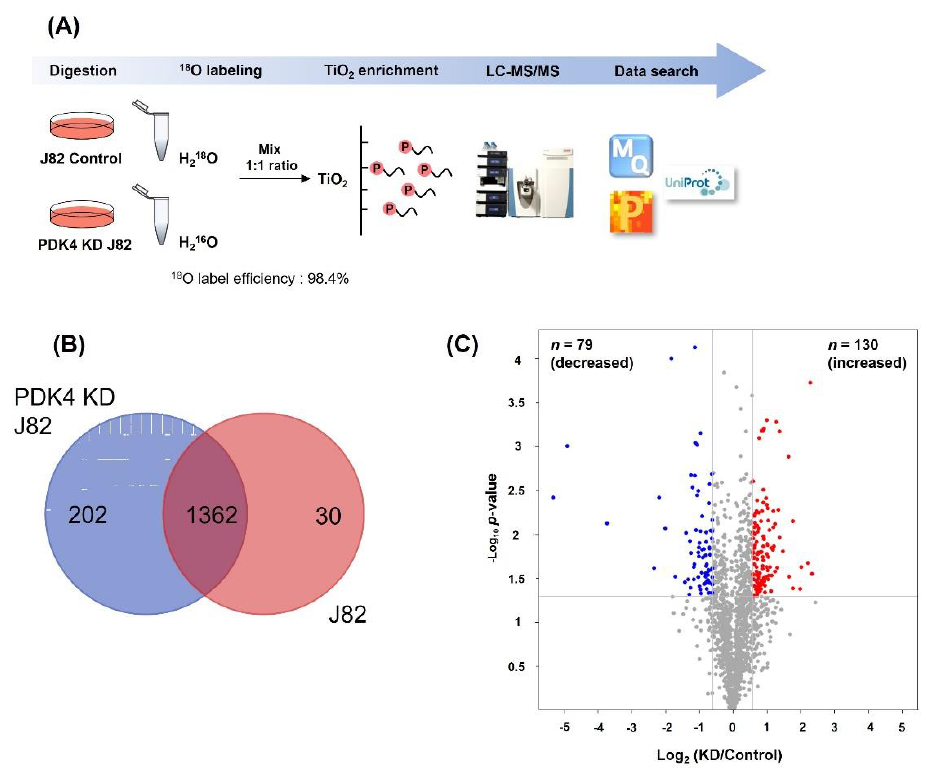
Figure 6. MS-based quantitative proteomic profiling of phosphorylation in bladder cancer cell lines. ( A ) Experimental design of proteomic analysis. J82 and J82 KD cells were lysed, subjected to in-solution digestion and 18 O labeling, and then mixed at equal protein amounts. Phosphorylated peptides were enriched by TiO 2 . Eluted peptides were analysis using LC-MS/MS. Mass spectrum data were searched in the MaxQuant (version 1.5) database. ( B ) Venn diagrams showing overlap between J82 knock down and J82 control. ( C ) Volcano plot for 209 differentially phosphorylated protein (DRPs) between PDK4 knockdown and controls.